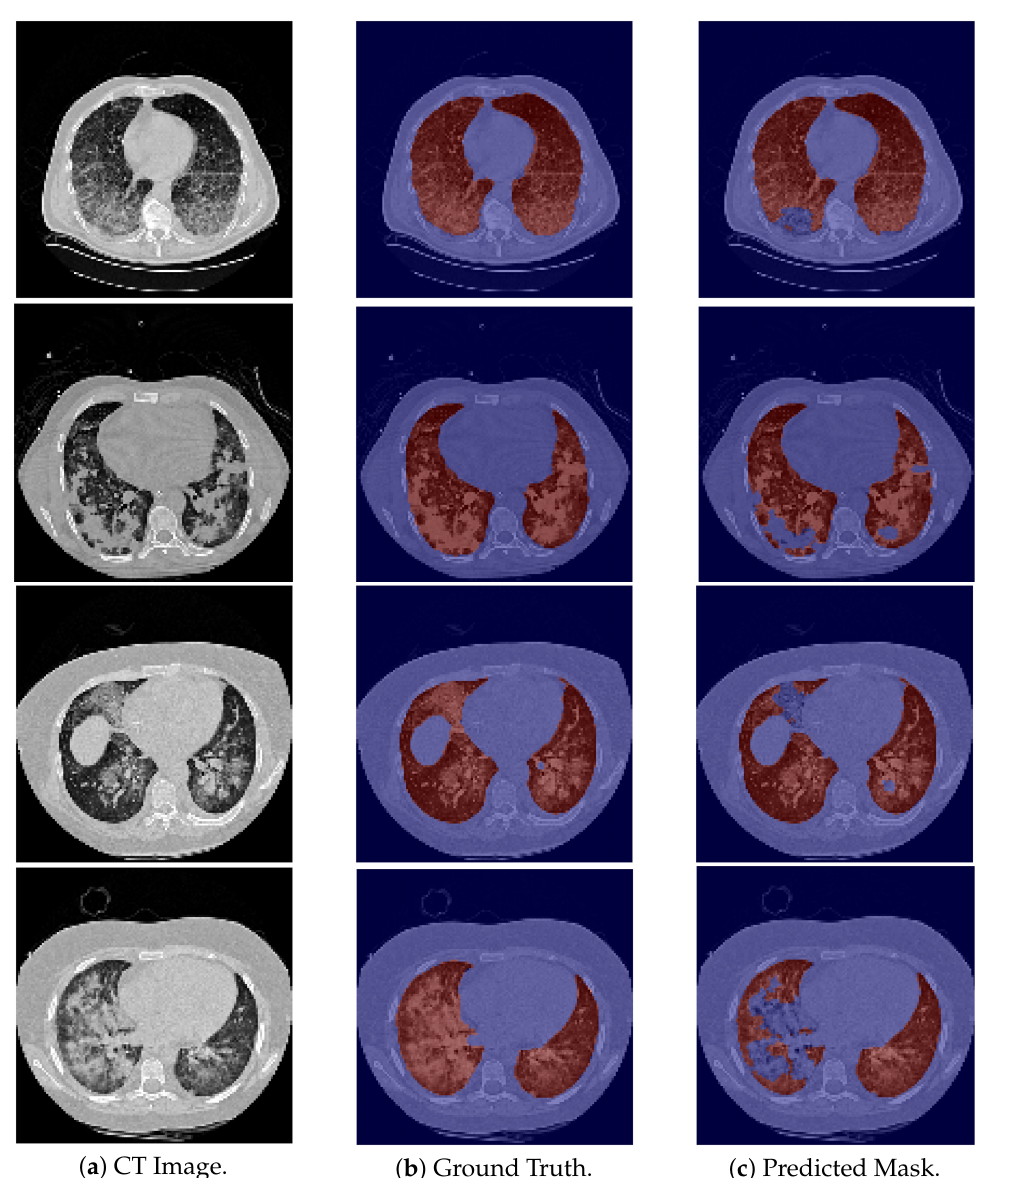
Figure 3. Examples of HUG-ILD images for pathological cases. The patterns of these images from top to bottom are, respectively, micronodules, bronchioectasis, emphysema, fibrosis, macronodules, reticulation with ground-glass, consolidation, ground-glass, and pneumocystis carinii pneumonia. For the last five examples, the model failed to segment part of the lung due to the pathological changes present in the